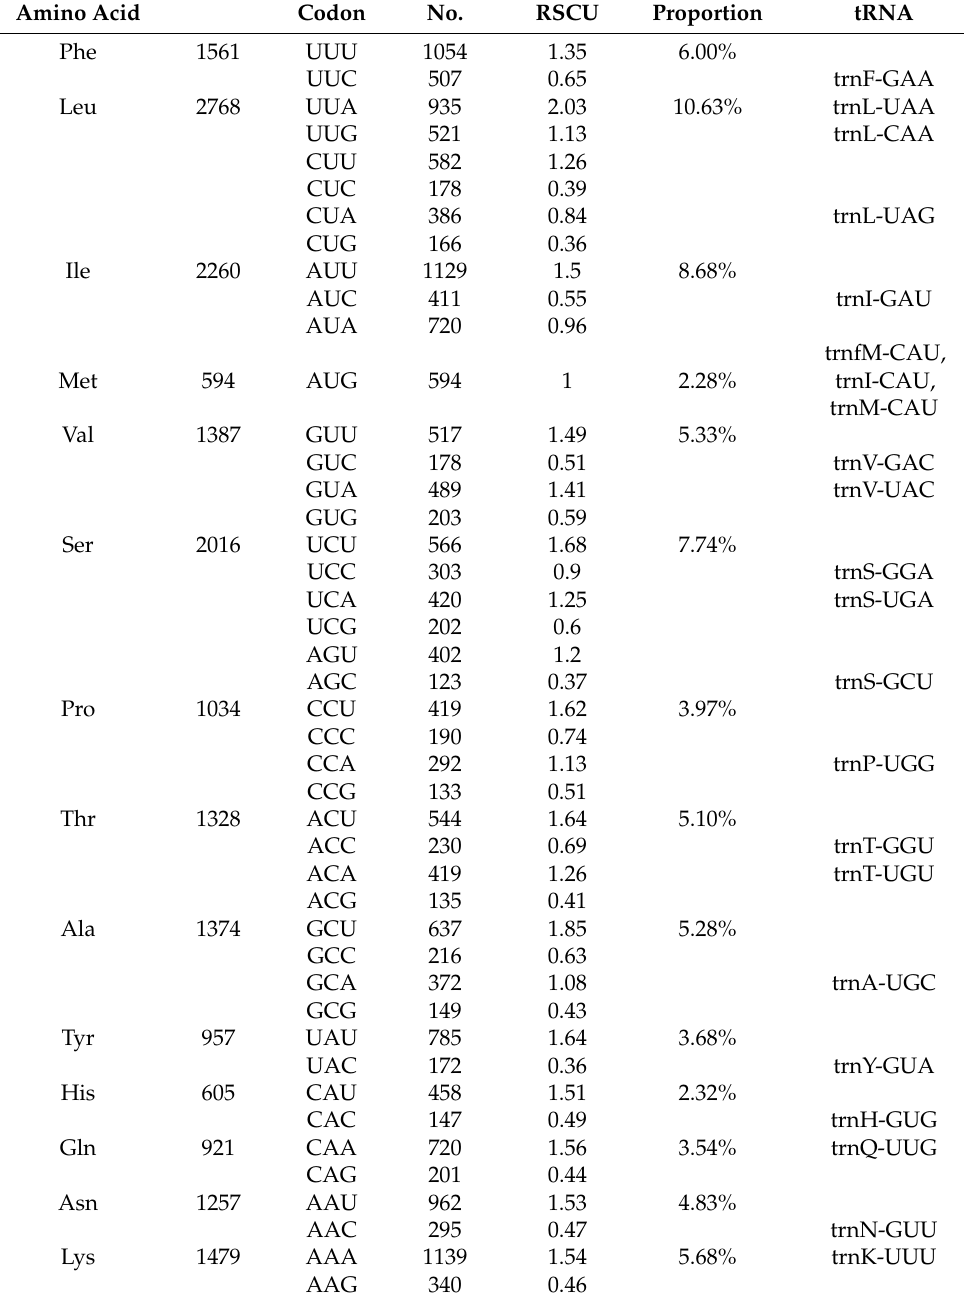
Table 3. Codon usage table of Cardamine hupingshanensis